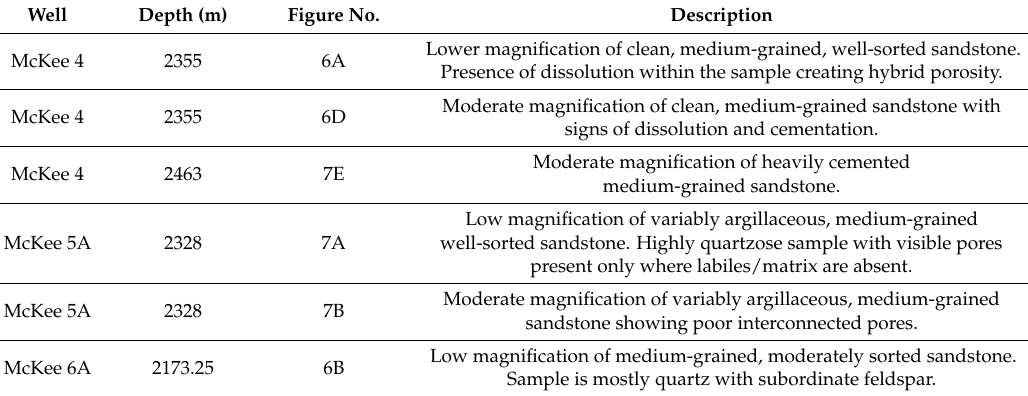
Table 1. Petrographic descriptions of the thin section photomicrographs provided by GNS Science. Figure No.